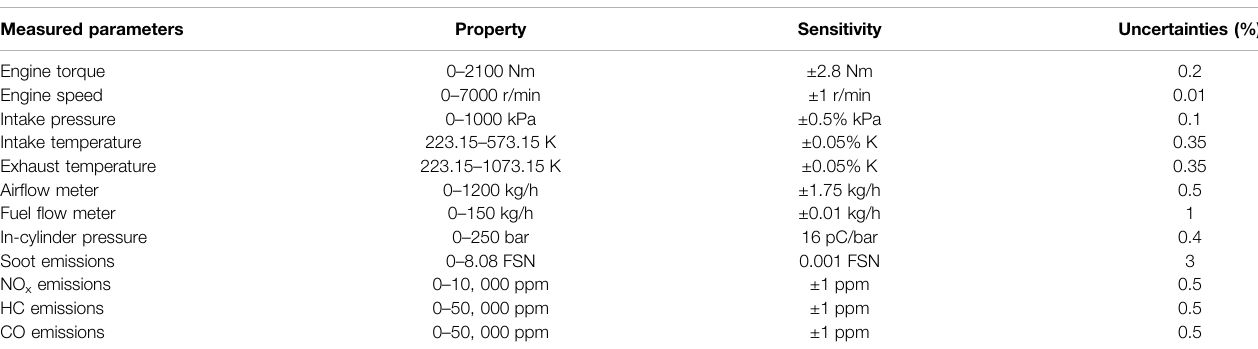
TABLE 2 | Uncertainties of measured